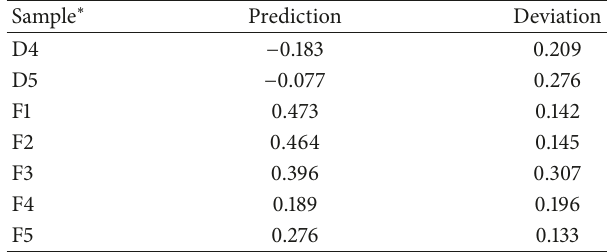
Table 2: Discriminant data for calibration set of mutton samples, fraud mutton samples, and other meat samples by PLS-DA